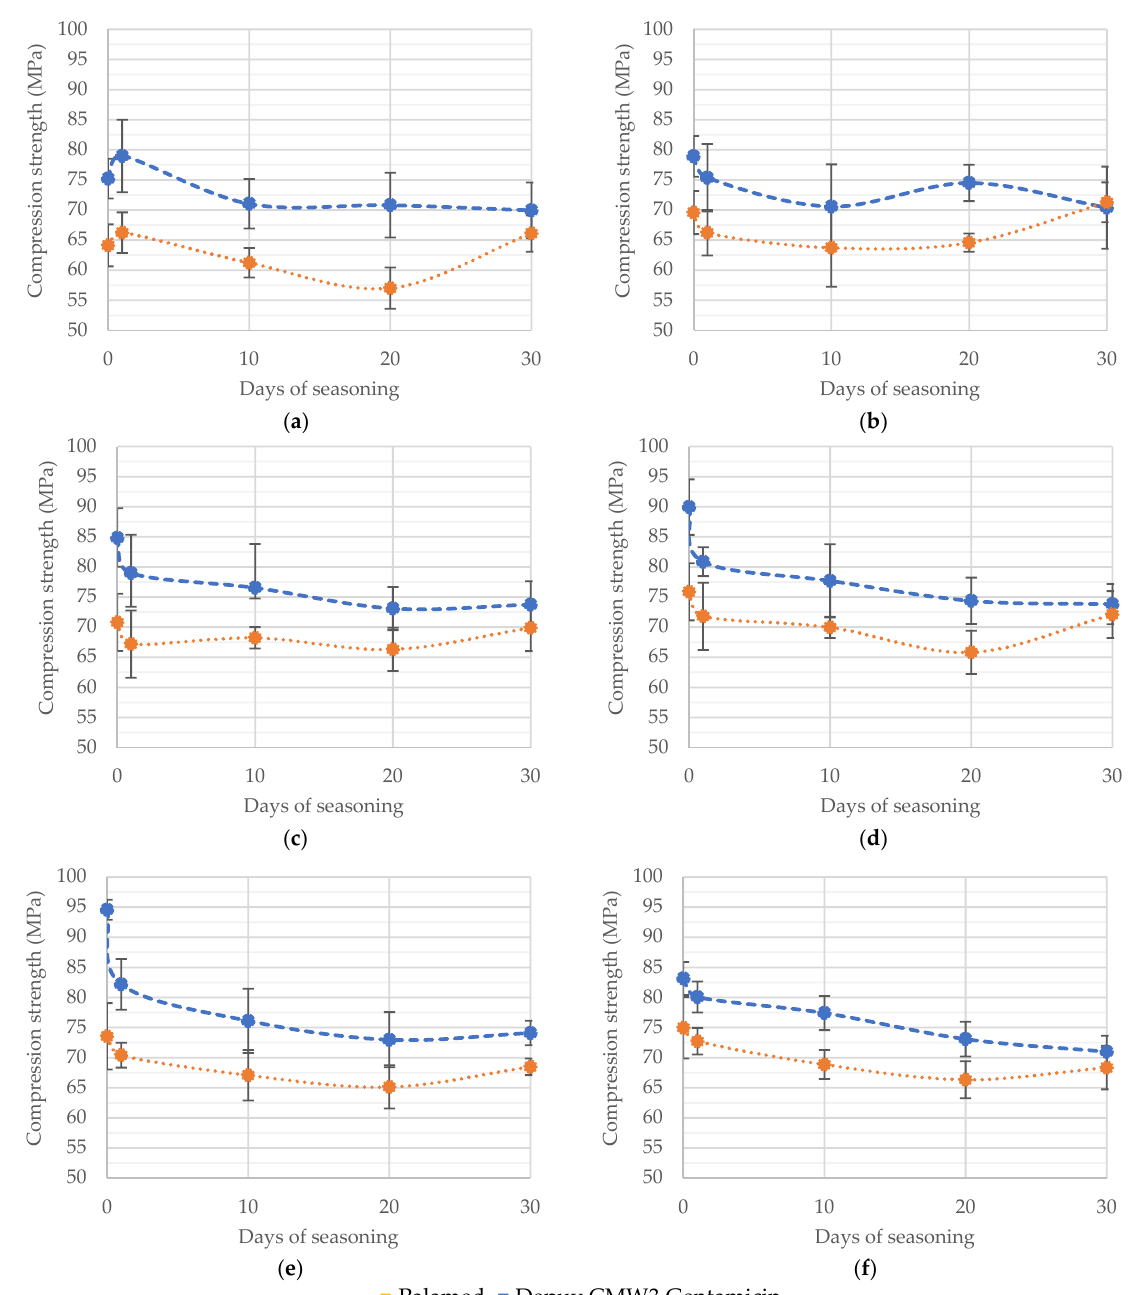
Figure 4. Change in average compressive strength of the cements tested as a function of their composition: ( a ) − 30% liquid part (l.p.), ( b ) − 15% l.p., ( c ) correct ratio, ( d ) +10% l.p., ( e ) +20% l.p., ( f ) +40% l.p.